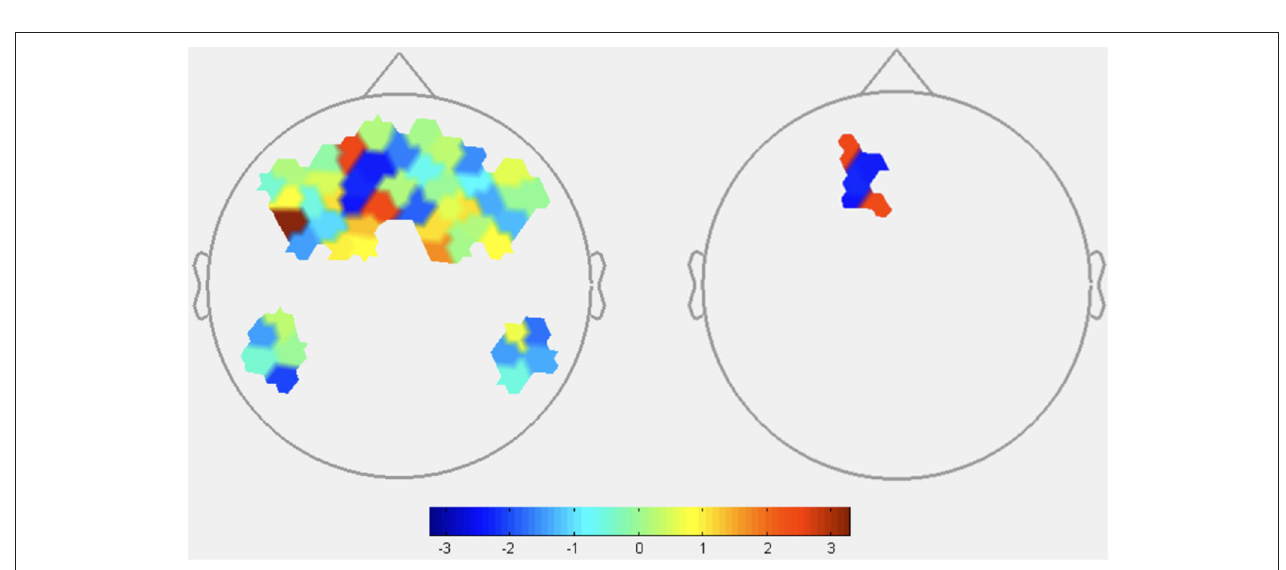
FIGURE 5 | HbR contrasts between low transparency and high transparency conditions: (T Low R Low + T low R High )–(T High R Low +T High R High ). Left image displays all t-values, right image displays t-values that are statistically significant ( p < 0.05). Red coloration indicates less activation (higher HbR) during low transparency conditions. Blue coloration indicates more activation (lower HbR) during high transparency